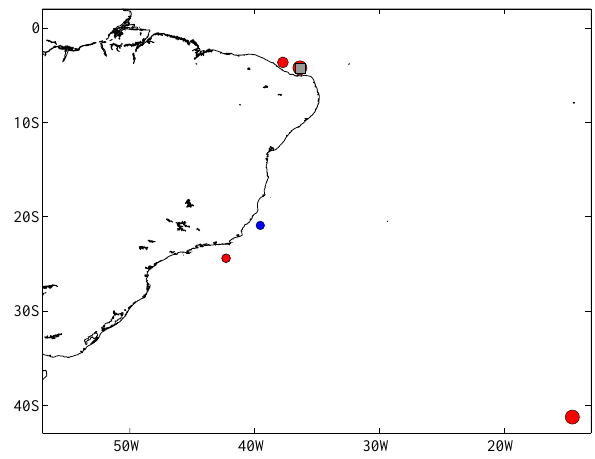
Fig. 8. MH sea surface temperature palaeodata off eastern South America. Symbol colours: blue circles, colder than present; red cir- cles, warmer than present; grey circles, similar to present; and grey squares, warmer–colder oscillation. Symbol size refers to palaeo- data Q -index (a chronological reliability index; see text for more information) values; larger symbols indicate higher Q -index val- ues. Vertical axis refers to latitude values, and horizontal axis refers to longitude